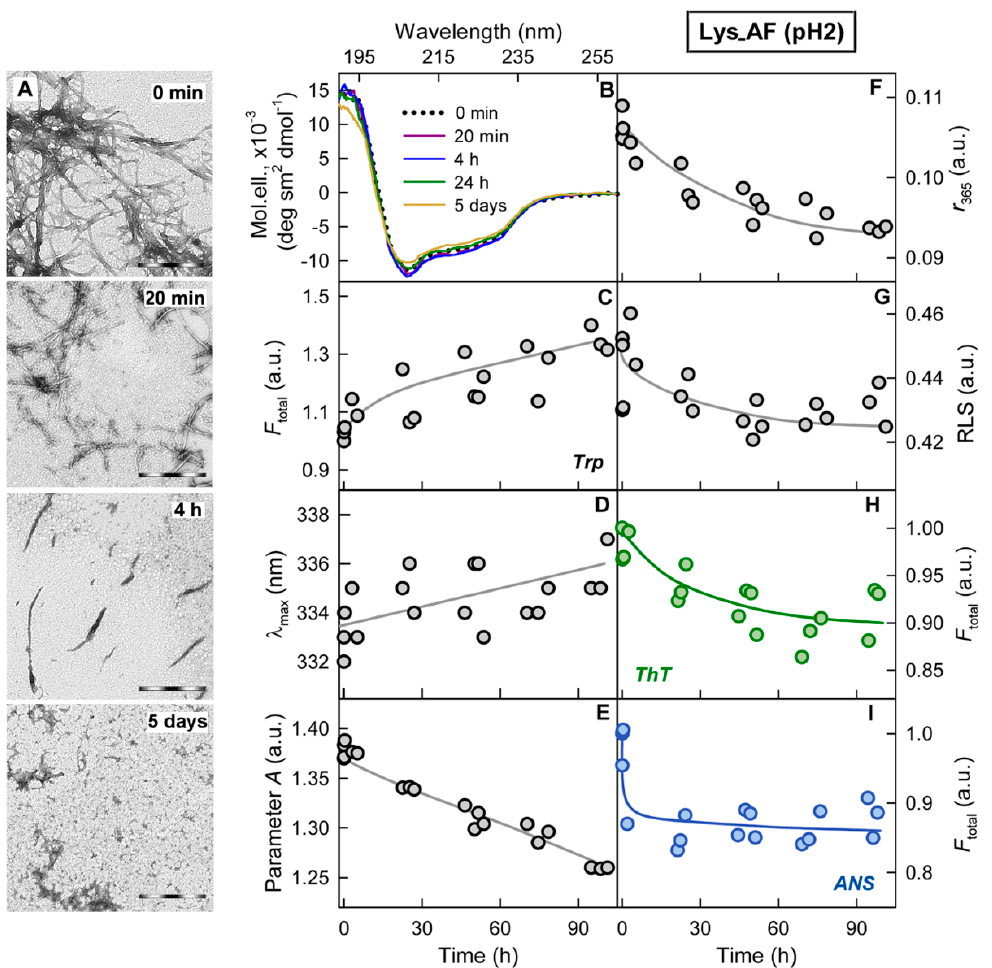
Figure 3. Trypsin ‐ induced degradation of amyloid fibrils formed from lysozyme at pH 2. ( A ) The electron micrographs of amyloid fibrils in the absence and at different time points after the addition of trypsin to the samples. Scale bars are equal to 1 μ m. ( B ) Changes in far UV CD spectra of amyloid samples. ( C ) Changes in total fluorescence intensity of amyloid fibrils at the excitation wavelength of 295 nm. ( D ) Changes in wavelength of the fluorescence spectrum maximum of amyloid fibrils ( λ max ). ( E ) Changes in parameter A of amyloid fibrils, λ ex = 295 nm. ( F ) Changes in fluorescence anisotropy of amyloid fibrils, λ ex = 295 nm, λ em = 365 nm. ( G ) Changes in Rayleigh Light Scattering of amyloid fibrils. ( H ) Changes in the total fluorescence intensity of ThT and ( I ) ANS in the presence of amyloid fibrils. The values at the panels ( C , H , I ) are normalized to the values for fibrils in the absence of the protease. The experiments were conducted under physiological conditions (pH 7.4), and weight ratio of fibrils to trypsin was kept at 125:1. The measurements were performed in 20 mM sodium phosphate buffer solution (pH 7.4). The standard error of the mean is determined for a confidence interval of 0.95 and does not exceed 10%.